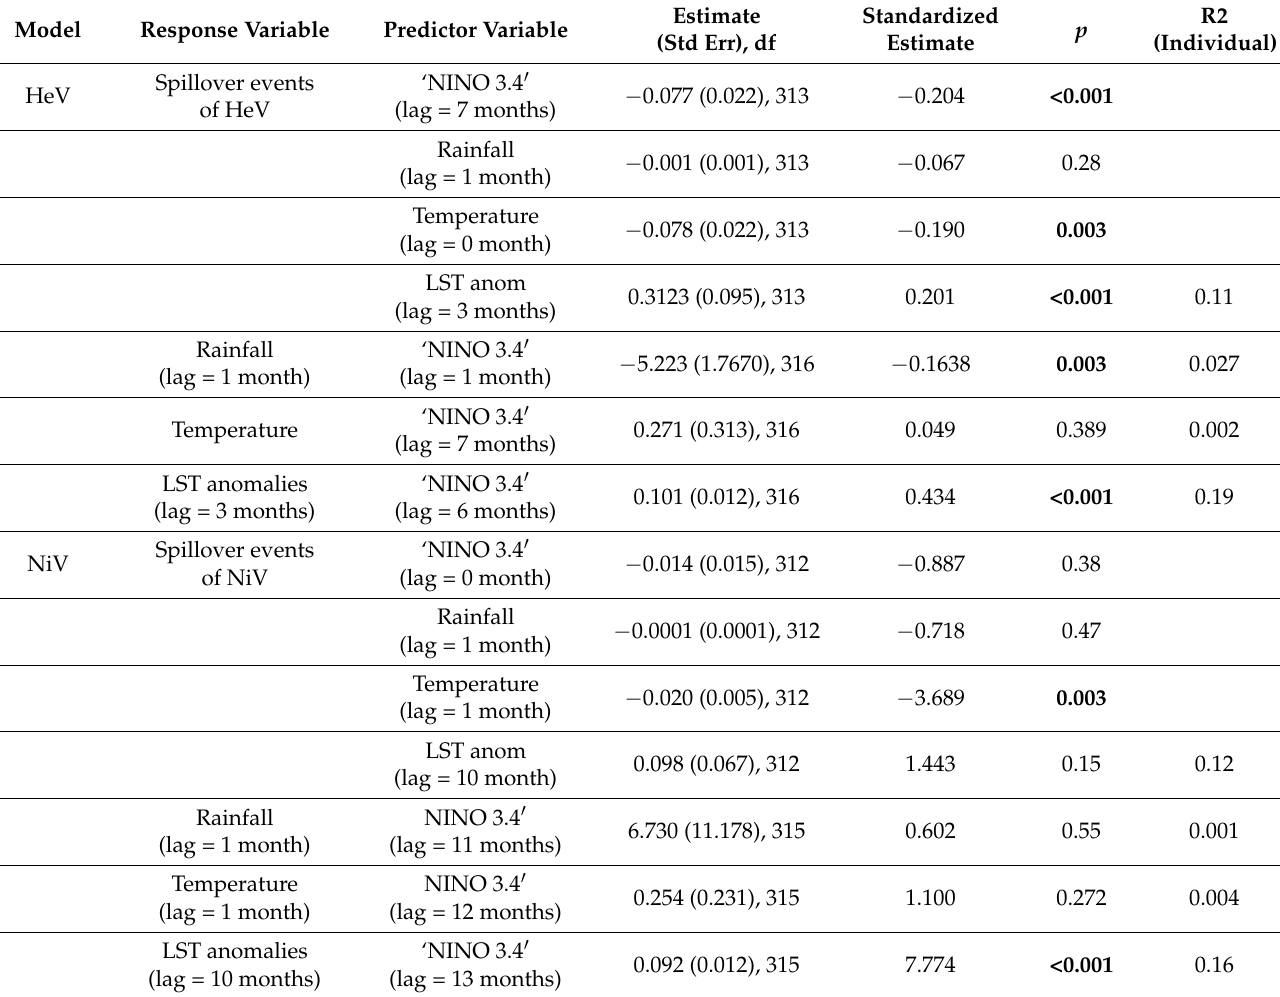
Table 6. Results of the structural equation modelling (SEM) to explore the temporal associations between spillover events of the Hendra virus (HeV) or the Nipah virus (NiV), the monthly tempera- ture, the monthly rainfall, the NINO 3.4 index, and land surface temperature (LST) anomalies from January 1991 to June 2020. Lag values were obtained from the time-series analyses and the logistic regression analyses (Table 4). Significant p -values are highlighted in